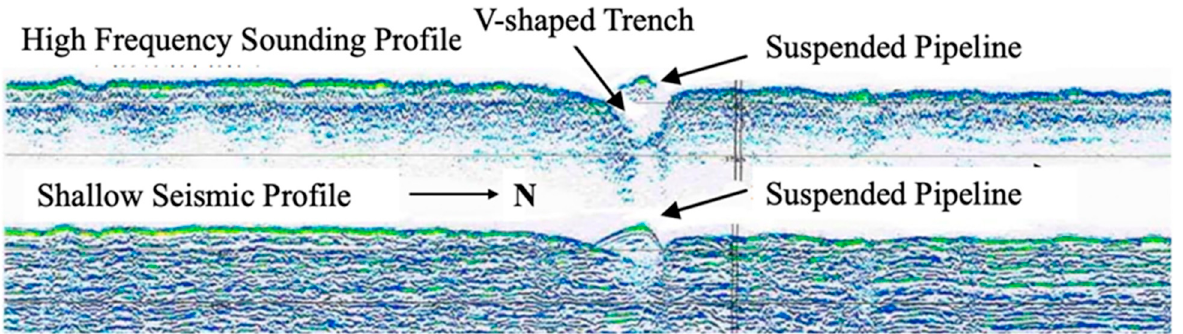
Figure 13. Shallow profile of suspended pipelines.